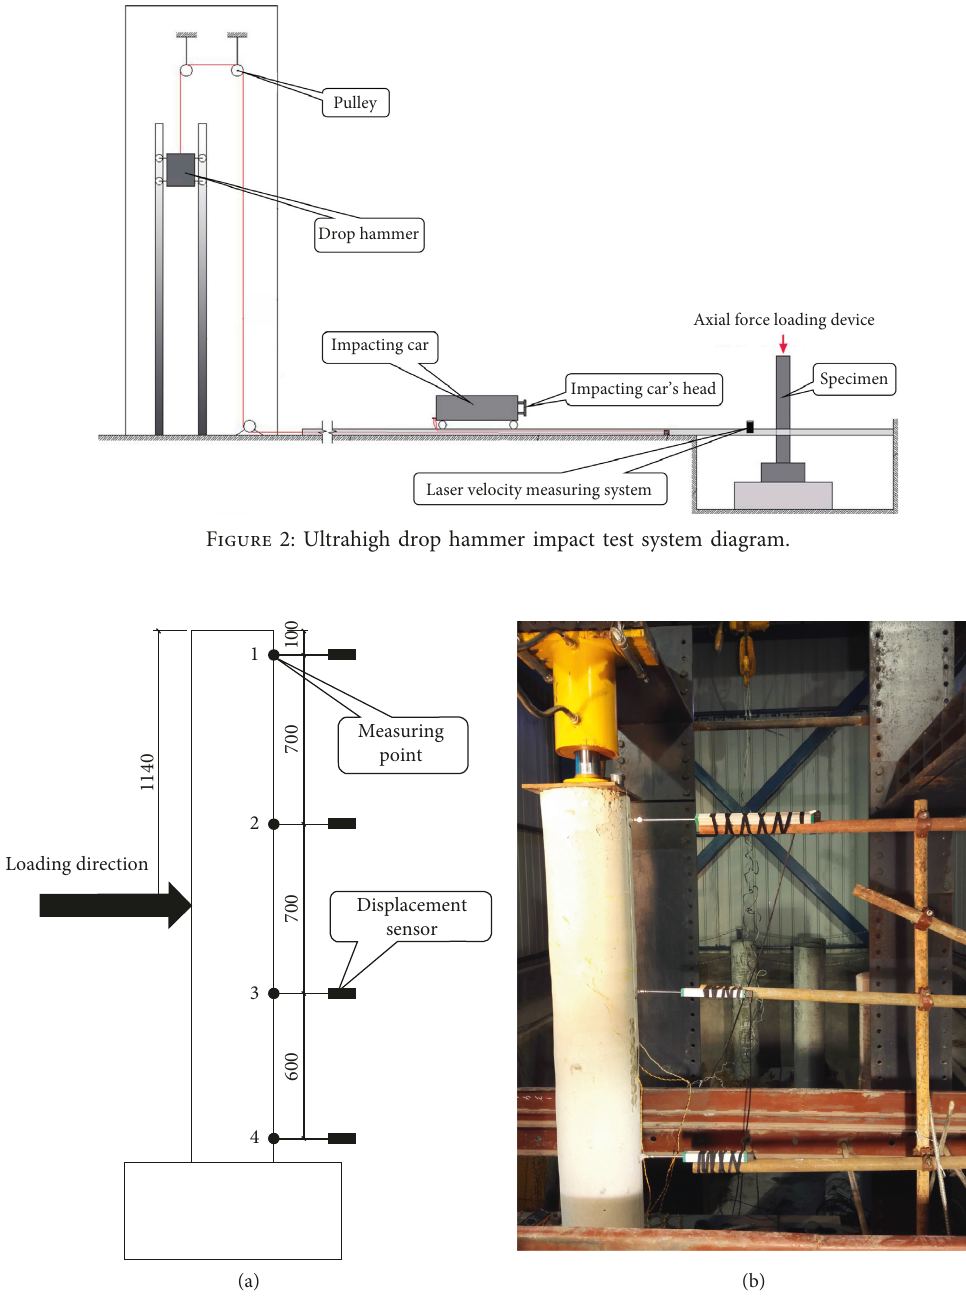
Figure 3: Arrangement diagram for displacement of specimen (unit: